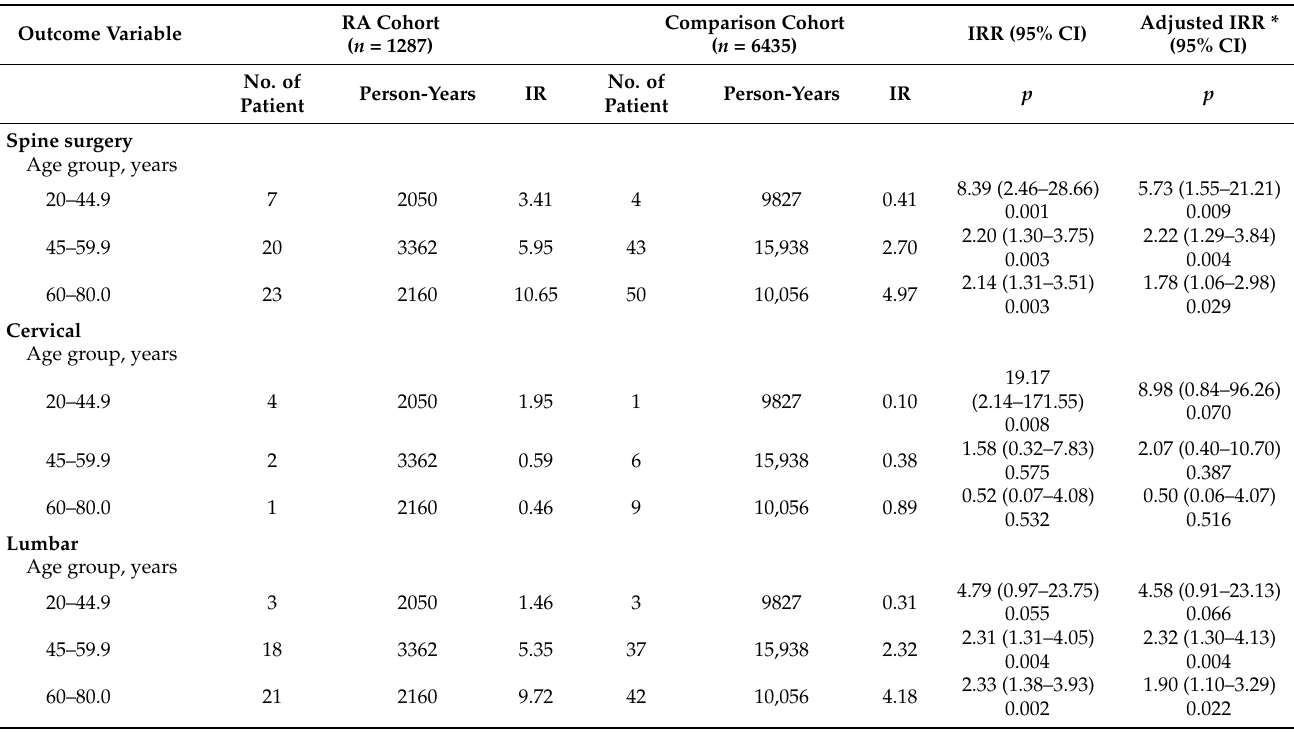
Table 3. The incidence rate and incidence risk ratio of spine surgery in the RA cohort and the comparison cohort ( n =